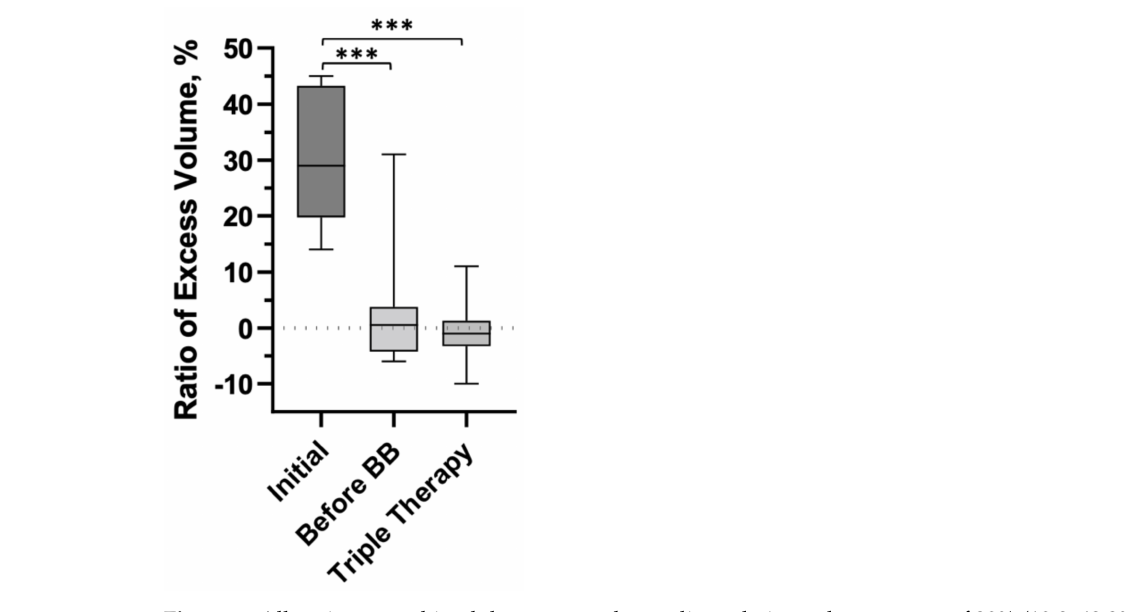
Figure 2. All patients combined demonstrated a median relative volume excess of 29% (19.8, 43.3%). Following liposuction and physiologic procedures, volume excess was 0.5% ( − 4.3, 3.8%, p < 0.0001). After BB placement and completion of triple therapy surgery, median volume excess was − 1 ( − 3.3, 1.3%, p < 0.0001). Data are presented as median values and IQR. Signficiant values ( p < 0.05) are indicated by (***).